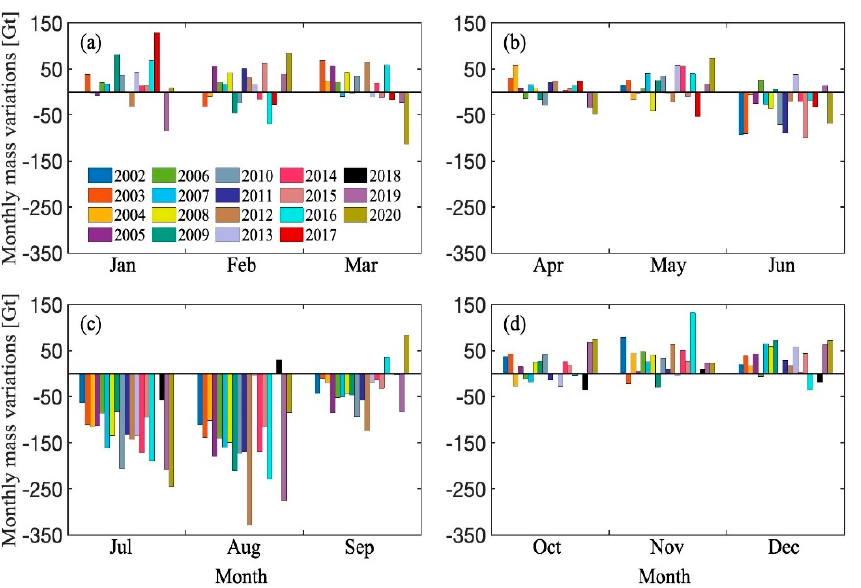
Figure 2. GRACE/GRACE-FO-derived non-cumulative mass change of the GrIS in the same month but different years (2002–2020). Non-cumulative mass change of the GrIS from January–March ( a ), April–June ( b ), July–September ( c ), October–December ( d ).